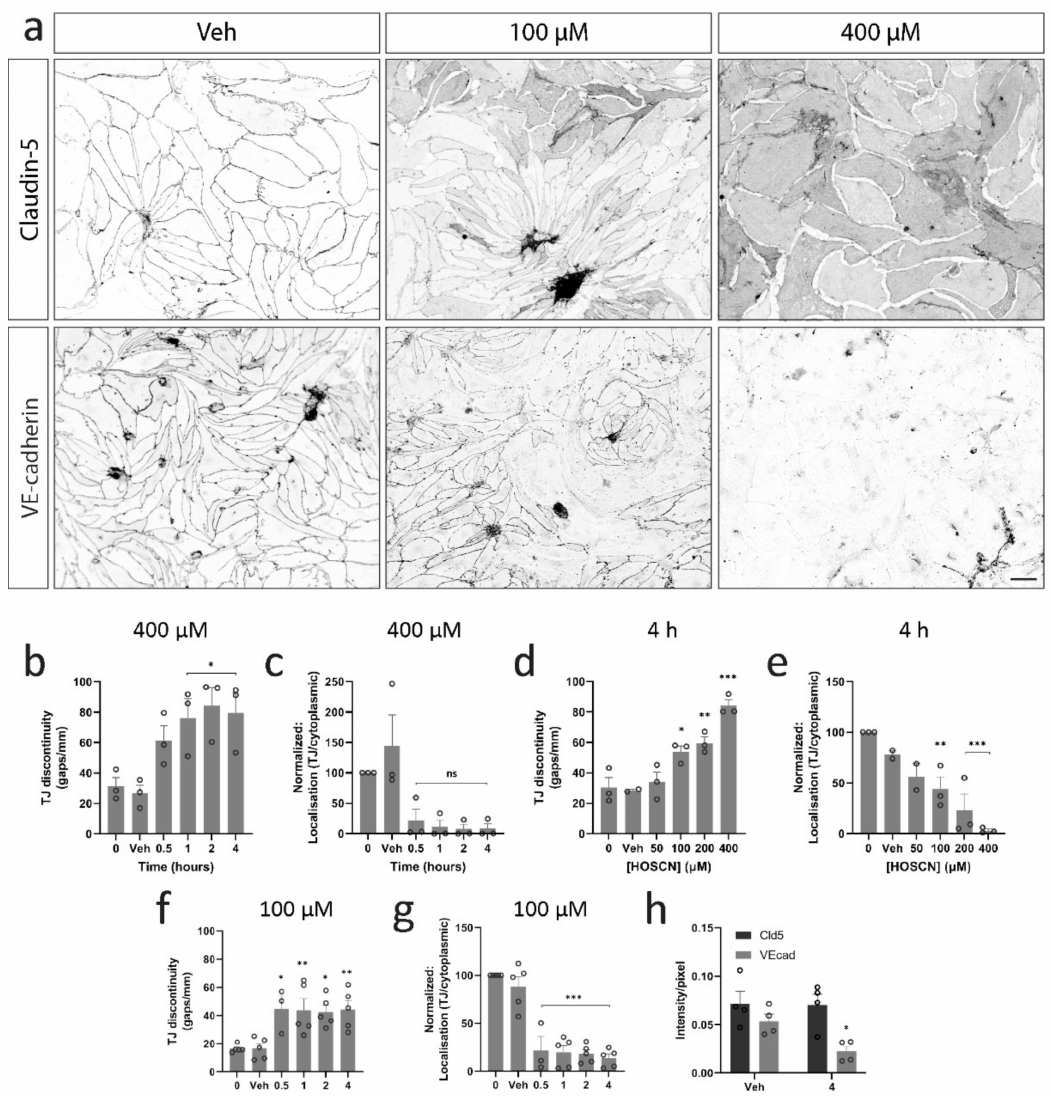
Figure 2. Hypothiocyanous acid (HOSCN) disrupts tight and adherens junctions in brain endothelial cells (BECs). BECs were exposed to 400 µ M HOSCN for various times or with increasing con- centrations of HOSCN for 4 h and then stained for junction proteins, claudin-5, and VE-cadherin. ( a ) Representative images of claudin-5 and VE-cadherin staining are shown with and without 400 µ M HOSCN treatment for 4 h. Gaps between endothelial cells and localisation changes for claudin-5 were quantified for ( b , c ) treatments with 400 µ M HOSCN for up to 4 h. n = 3, and ( d , e ) for treatments with different concentrations of HOSCN for 4 h. n = 3, and ( f , g ) for cells treated with 100 µ M HOSCN for up to 4 h. n = 3–5. One-way ANOVA; *— p < 0.05, **— p < 0.01, ***— p < 0.001 vs. vehicle control. ( h ) Fluorescent intensity of both claudin-5 and VE-cadherin was measured. n = 4. Scalebar = 50 µ m. Two-way ANOVA; *— p < 0.05 vs. vehicle